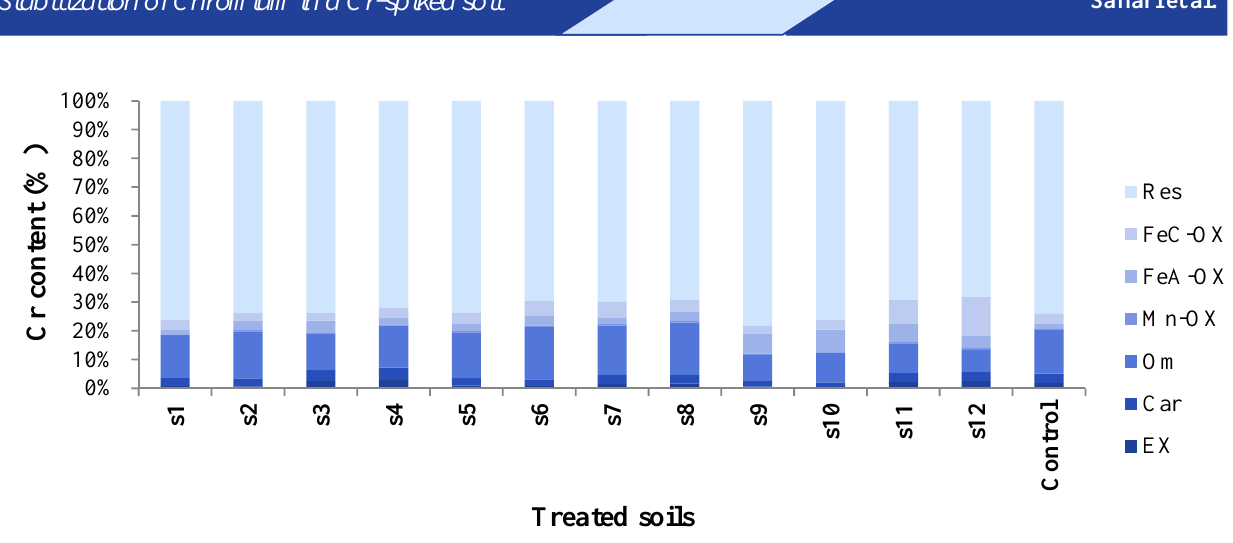
Figure 2. Percentages of various fractions of Cr in amended soil Fe 0 , MSWC, and B300 treatments significantly decreased